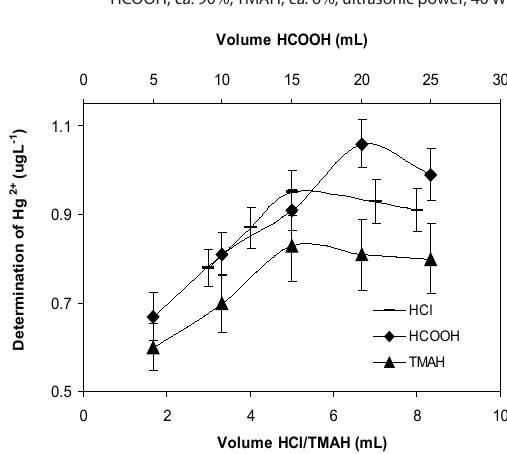
Figure 4. Effect of volume of extractant on CVAAS response from 1 µg L -1 solutions of Hg 2+ from DOLT-2 (HCl, 5 mol L -1 ; HCOOH, ca. 90%; TMAH, ca. 6%; ultrasonication time, 5 min; ultrasonic power, 40 W).